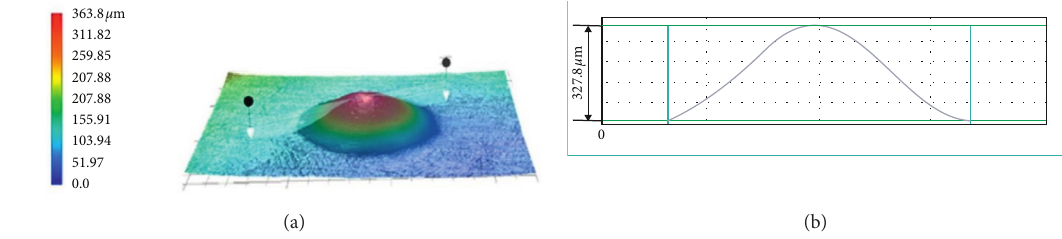
Figure 4: Three-dimensional (3D) profile and forming depth of the formed part.